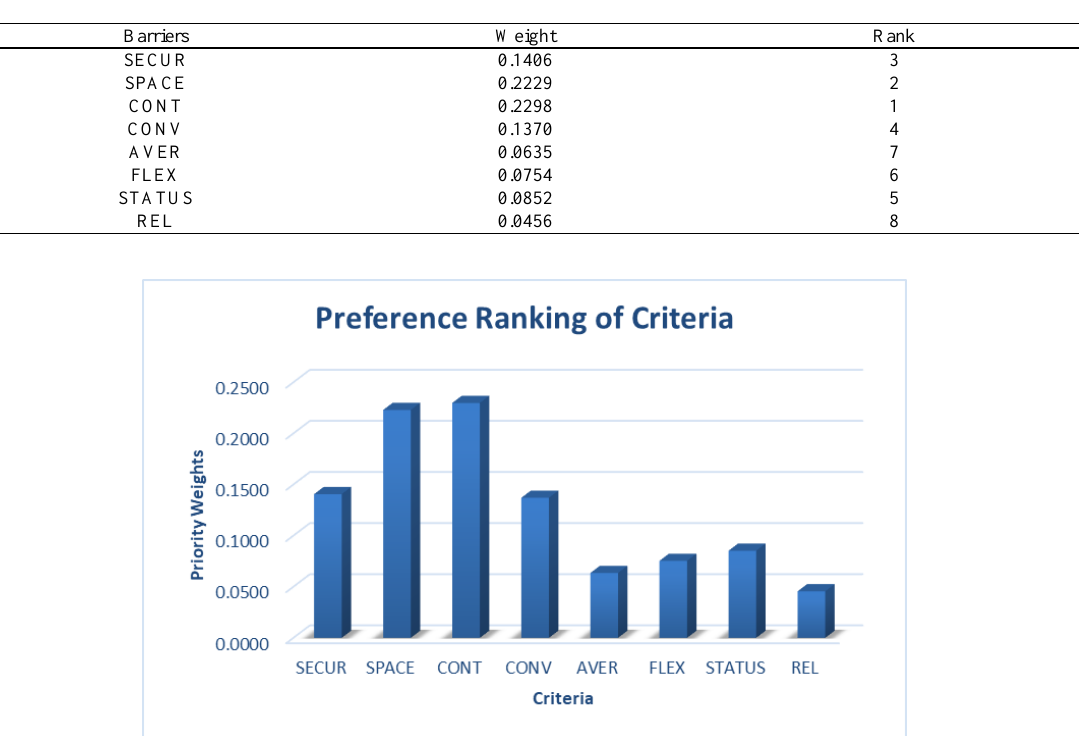
Table 5. Final weights and preference ranking of barriers.